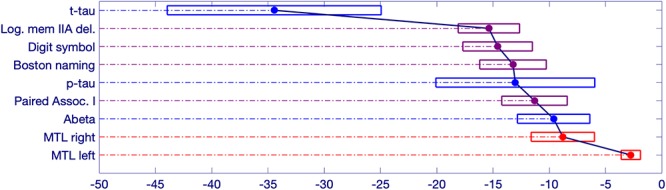
Schematic representation of significant changepoint results in relation to symptom onset. The estimated onset of clinical symptoms is represented by the value of 0 at the bottom right side of the figure. The numbers to the left of the 0 represent the estimated number of years prior to symptom onset for the changepoint of each variable. The width of each box represents a bias-corrected 75% confidence interval for the estimated value of each variable.